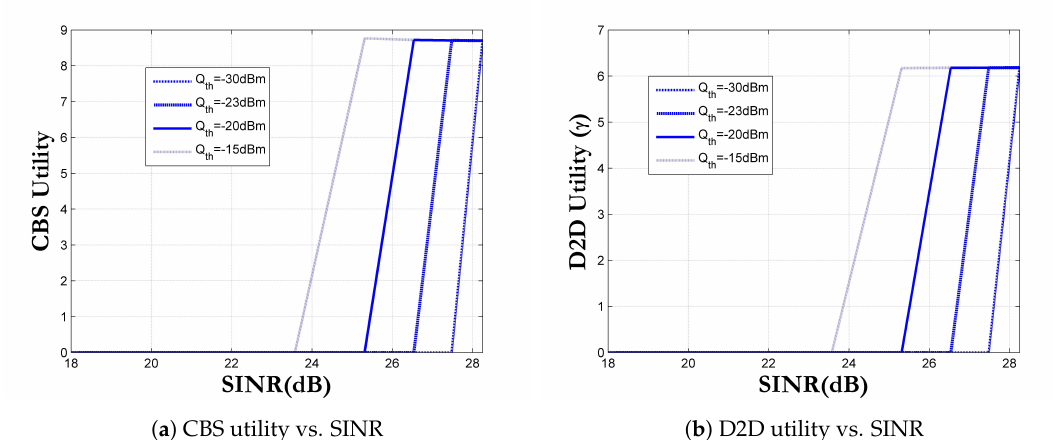
Figure 4. Utilities achieved using the proposed